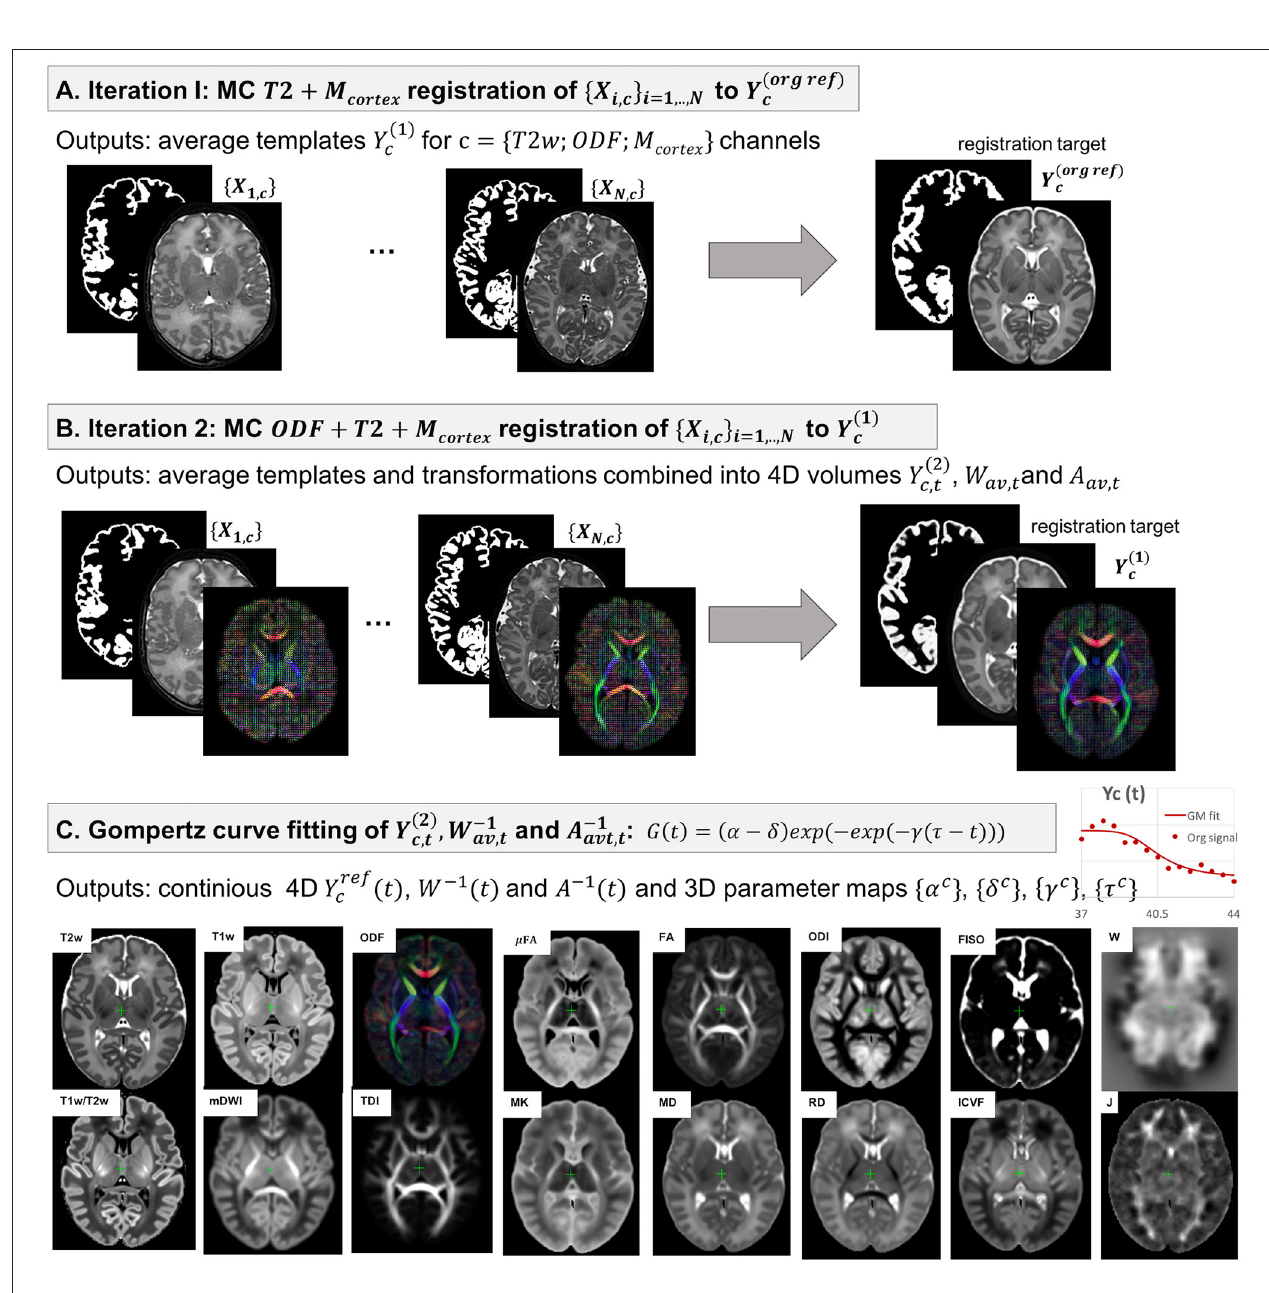
FIGURE 3 | The proposed pipeline for generation of parametrized 4D MC atlas of neonatal brain development during 37–44 weeks PMA range.